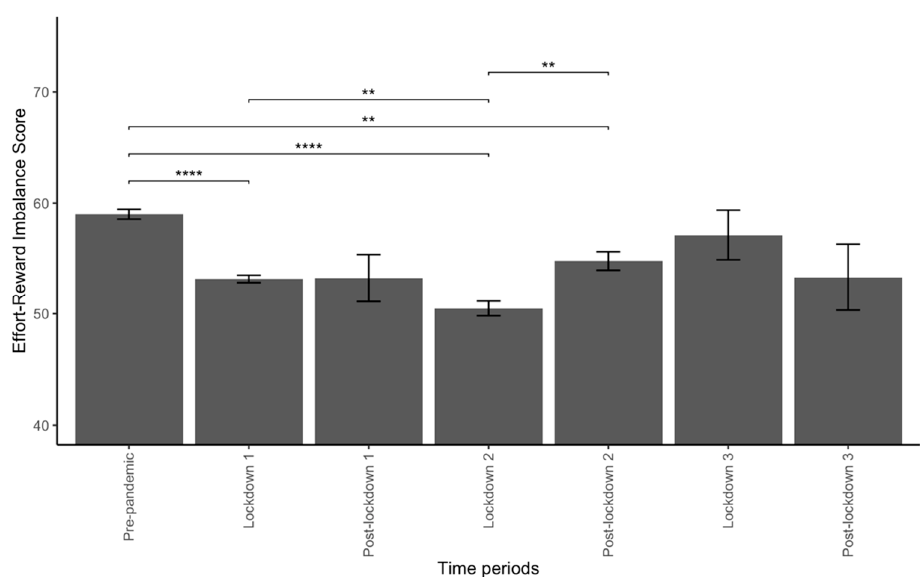
Figure 2. Effort-Reward Imbalance (ERI) score across the periods of interest. Abbreviations: **: <0.01; ****: <0.0001.